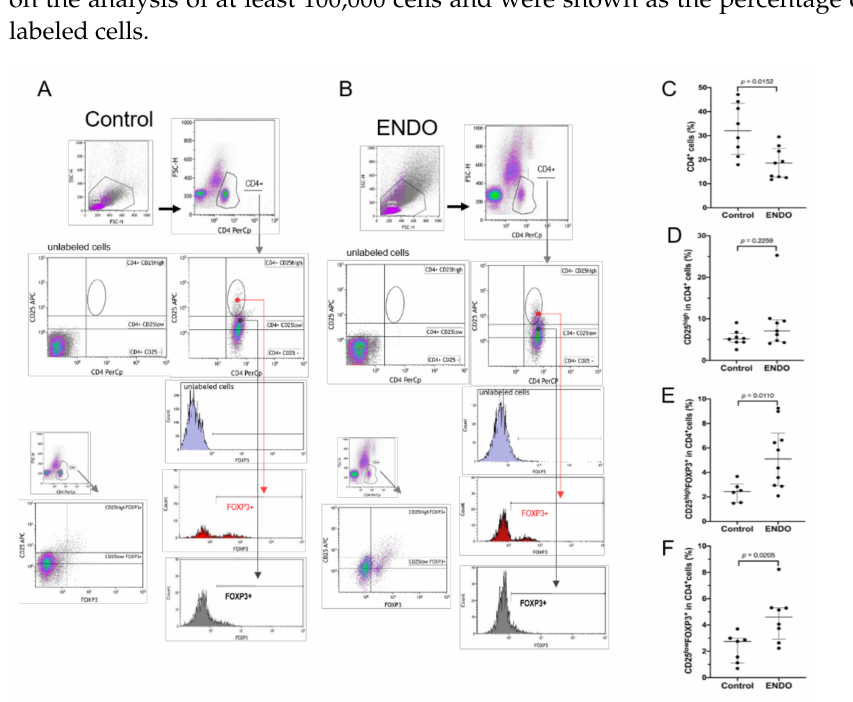
Figure 1. Flow cytometry gating strategy and analysis of the proportion of Treg cells in the peritoneal fluid from control women (Control) and patients with endometriosis (ENDO). Figure includes a repre- sentative flow cytometry analysis showing identification of the respective T cell populations in both ( A ) control and ( B ) endometriosis groups. The analysis included evaluation of the proportion of ( C ) CD4 + , ( D ) CD4 + CD25 high , ( E ) CD4 + CD25 high FOXP3 + , and ( F ) CD4 + CD25 low FOXP3 + T cell populations as described in the Materials and Methods section. The results are shown as median and interquartile range. Statistical differences between groups were tested by two-tailed Mann–Whitney U